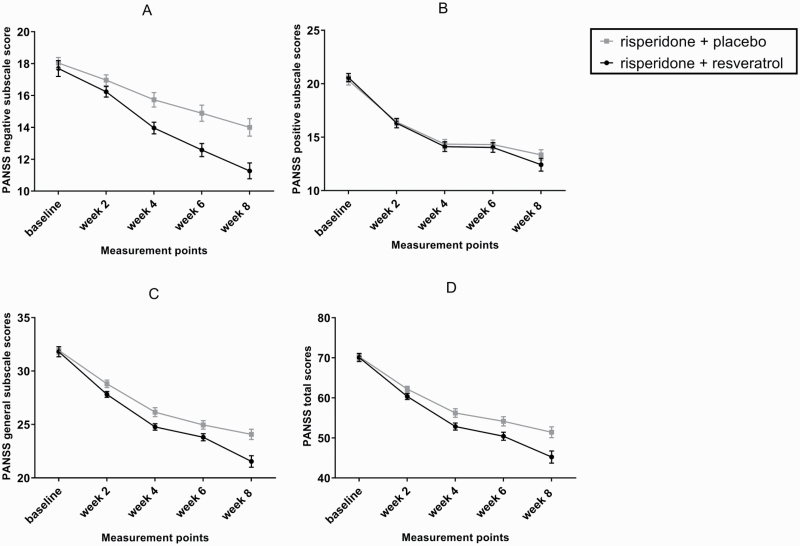
Repeated-measure ANOVA for comparison of the effects of 2 treatment strategies on the negative subscale of positive and negative syndrome scale (A), positive subscale of positive and negative syndrome scale (B), general psychopathology subscale of positive and negative syndrome scale (C), and positive and negative syndrome scale (D). Values represent mean ± SEM.